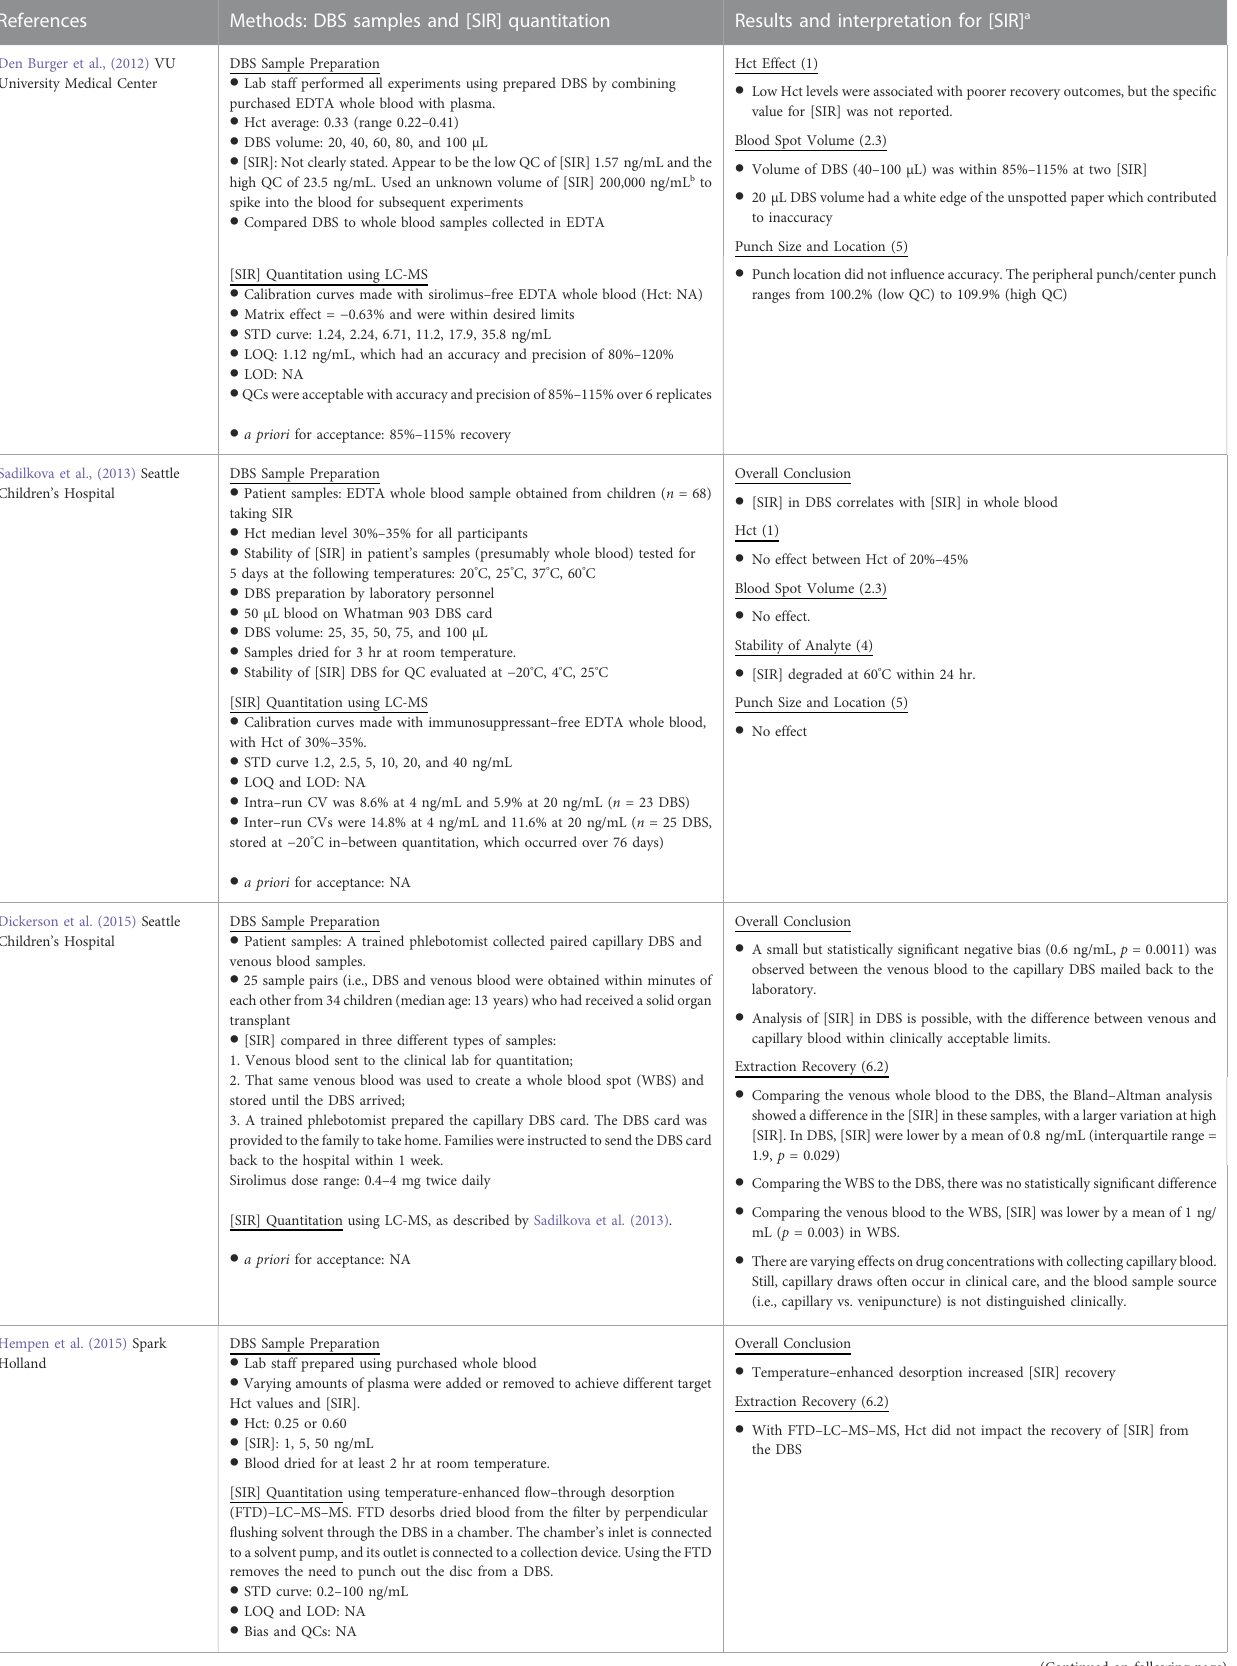
TABLE 3 Studies to quantitate sirolimus concentrations ([SIR]) in dried blood spots prepared in the laboratory or obtained from patients taking sirolimus. Publications are organized in order of publication of the researcher group, starting with the group ’ s oldest